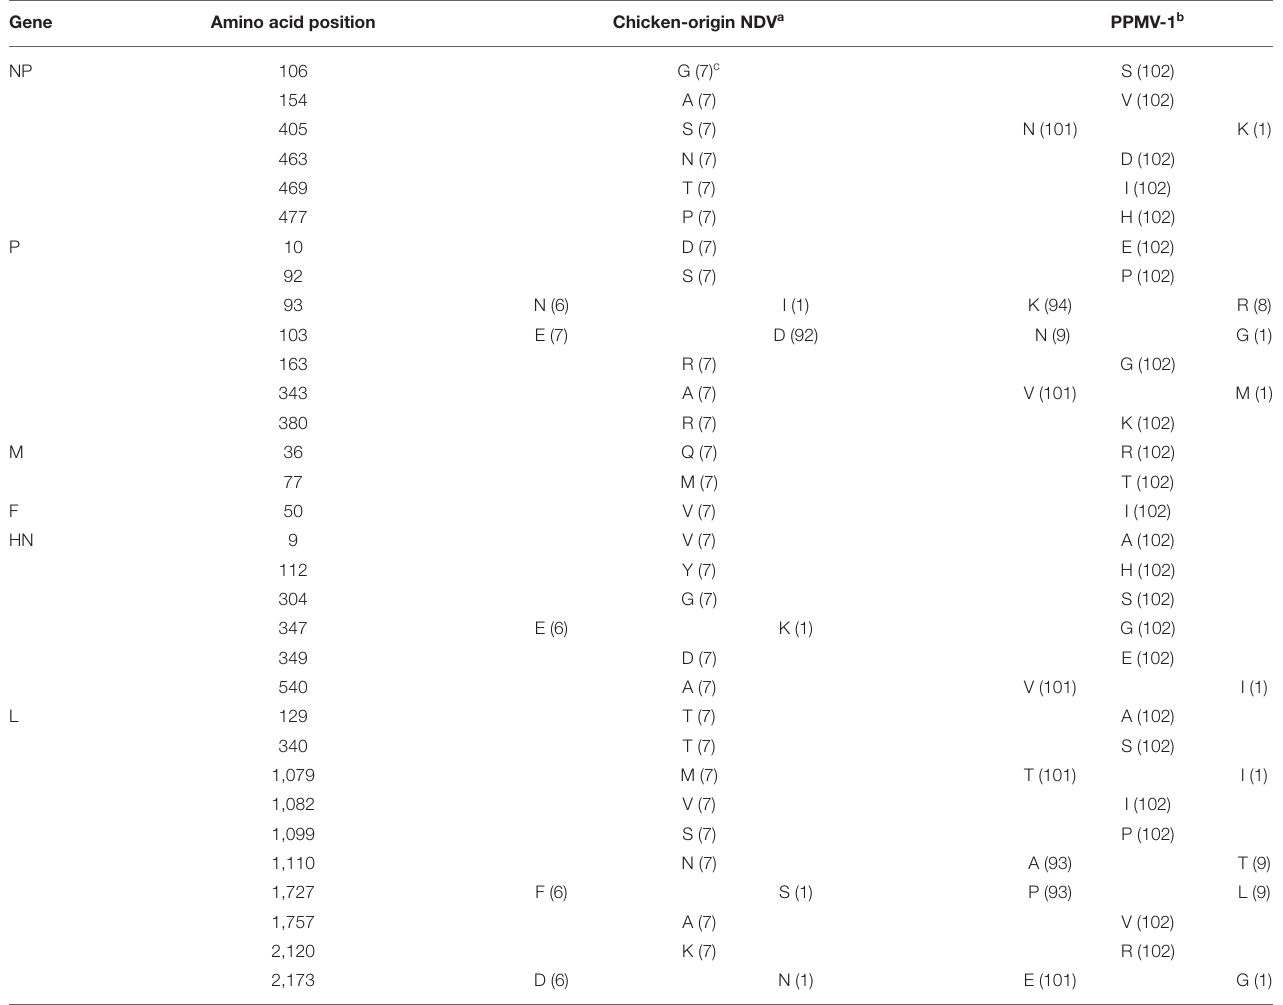
TABLE 5 | The special amino acid substitutions in different proteins of PPMV-1 compared with chicken-origin NDV. Gene Amino acid position Chicken-origin NDV a